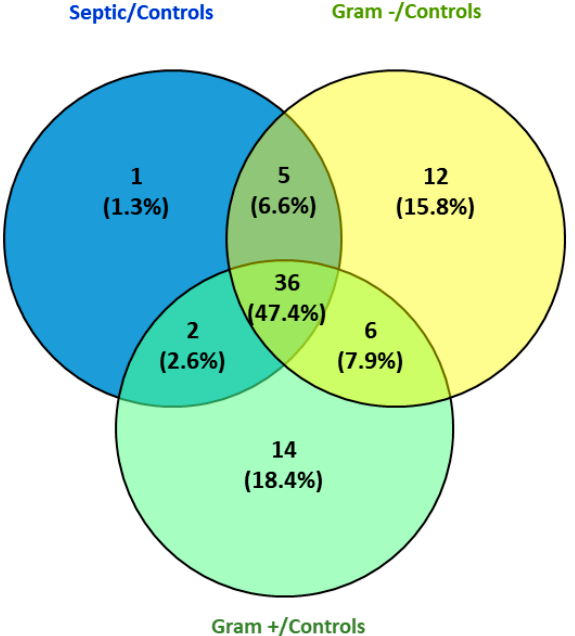
Figure 1. Significantly deregulated proteins among different groups.